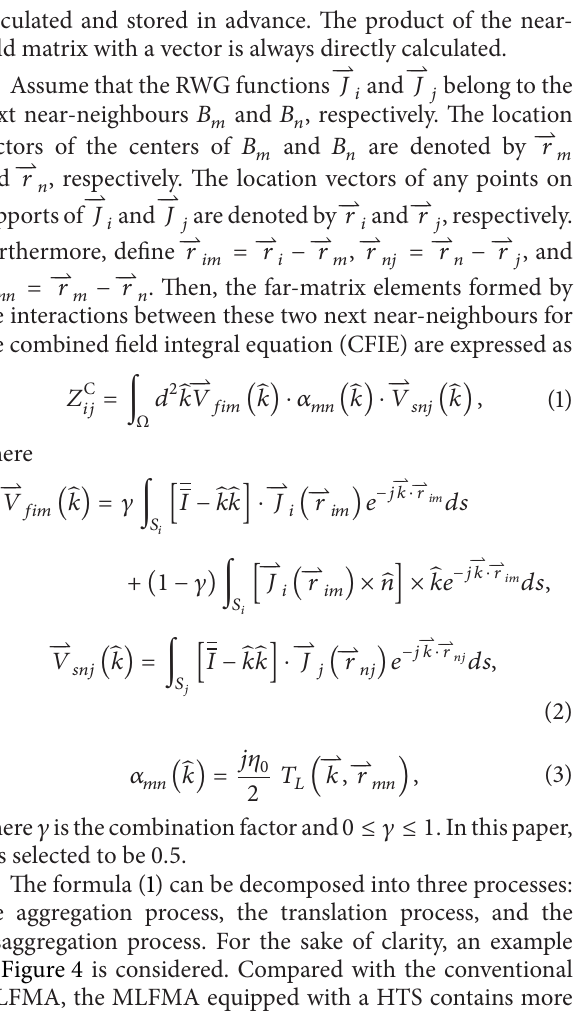
Figure 3: An observed box (ob) at the bottom layer and all its near- neighbours (nb) and all next near-neighbours